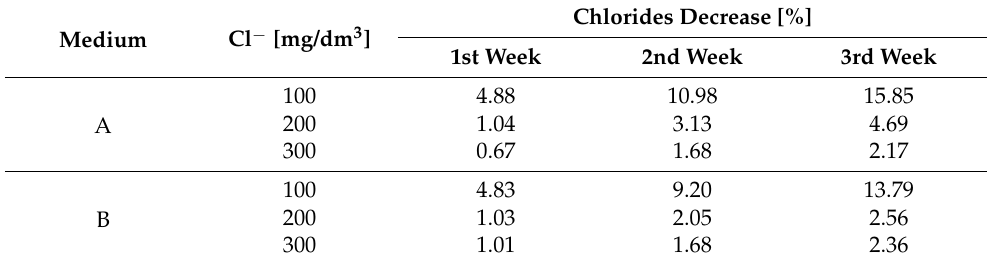
Table 4. The chloride ion movement during the process of biodegradation. Medium